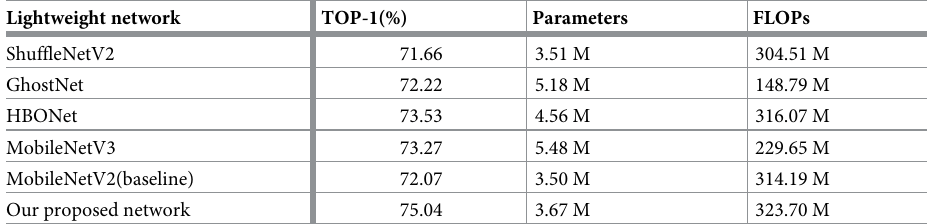
Table 8. TOP-1 accuracies on on ImageNet-1K dataset.